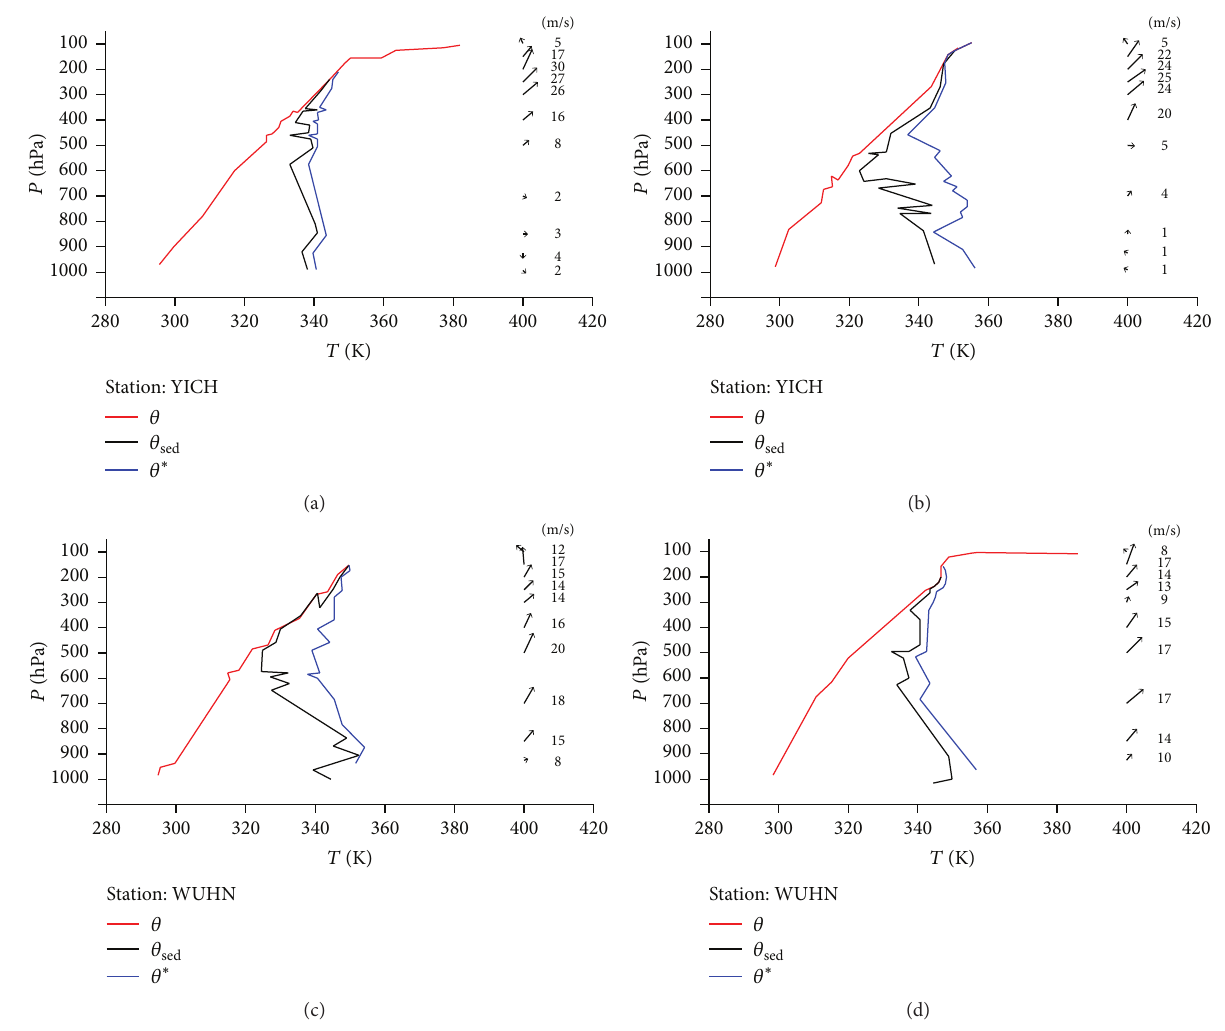
Figure 5: 𝑉 - 3𝜃 distribution conditions: (a) 8:00 a.m. on July 25, 2007, at the YICH station; (b) 8:00 p.m. on July 25, 2007, at the YICH station; (c) 8:00 a.m. on July 25, 2007, at the WUHN station; (d) 8:00 p.m. on July 25, 2007, at the WUHN station. The red lines are the 𝜃 curves, the green lines are the 𝜃 sed curves, and the blue lines are the 𝜃 ∗ curves.